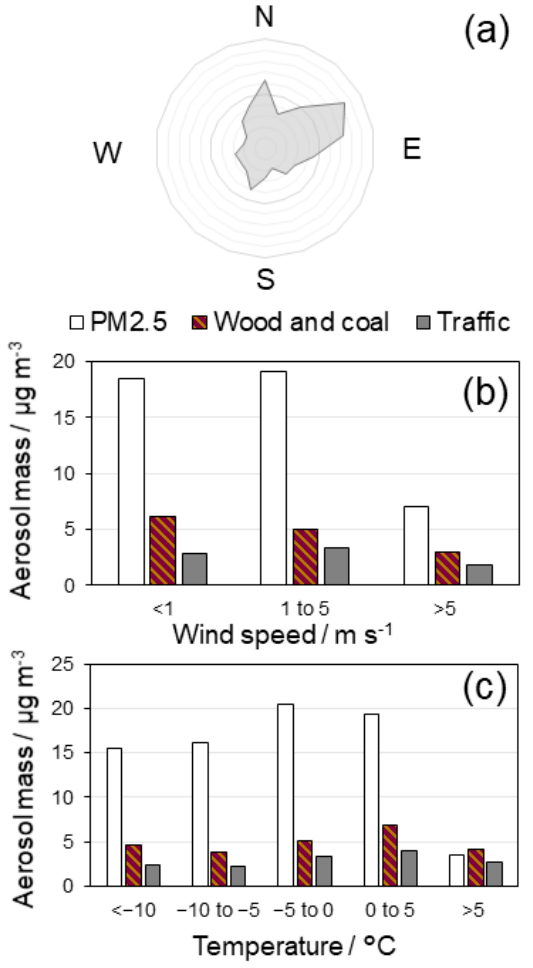
Figure 5. ( a ) Wind directions at the field site Diabła G ó ra and average CM source contributions from Figure 5. (a) Wind directions at the field site Diab ł a Góra and average CM source contributions from tra ffi c and wood / coal sources versus ( b ) wind speed and ( c ) versus traffic and wood/coal sources versus ( b ) wind speed and ( c ) versus temperature.